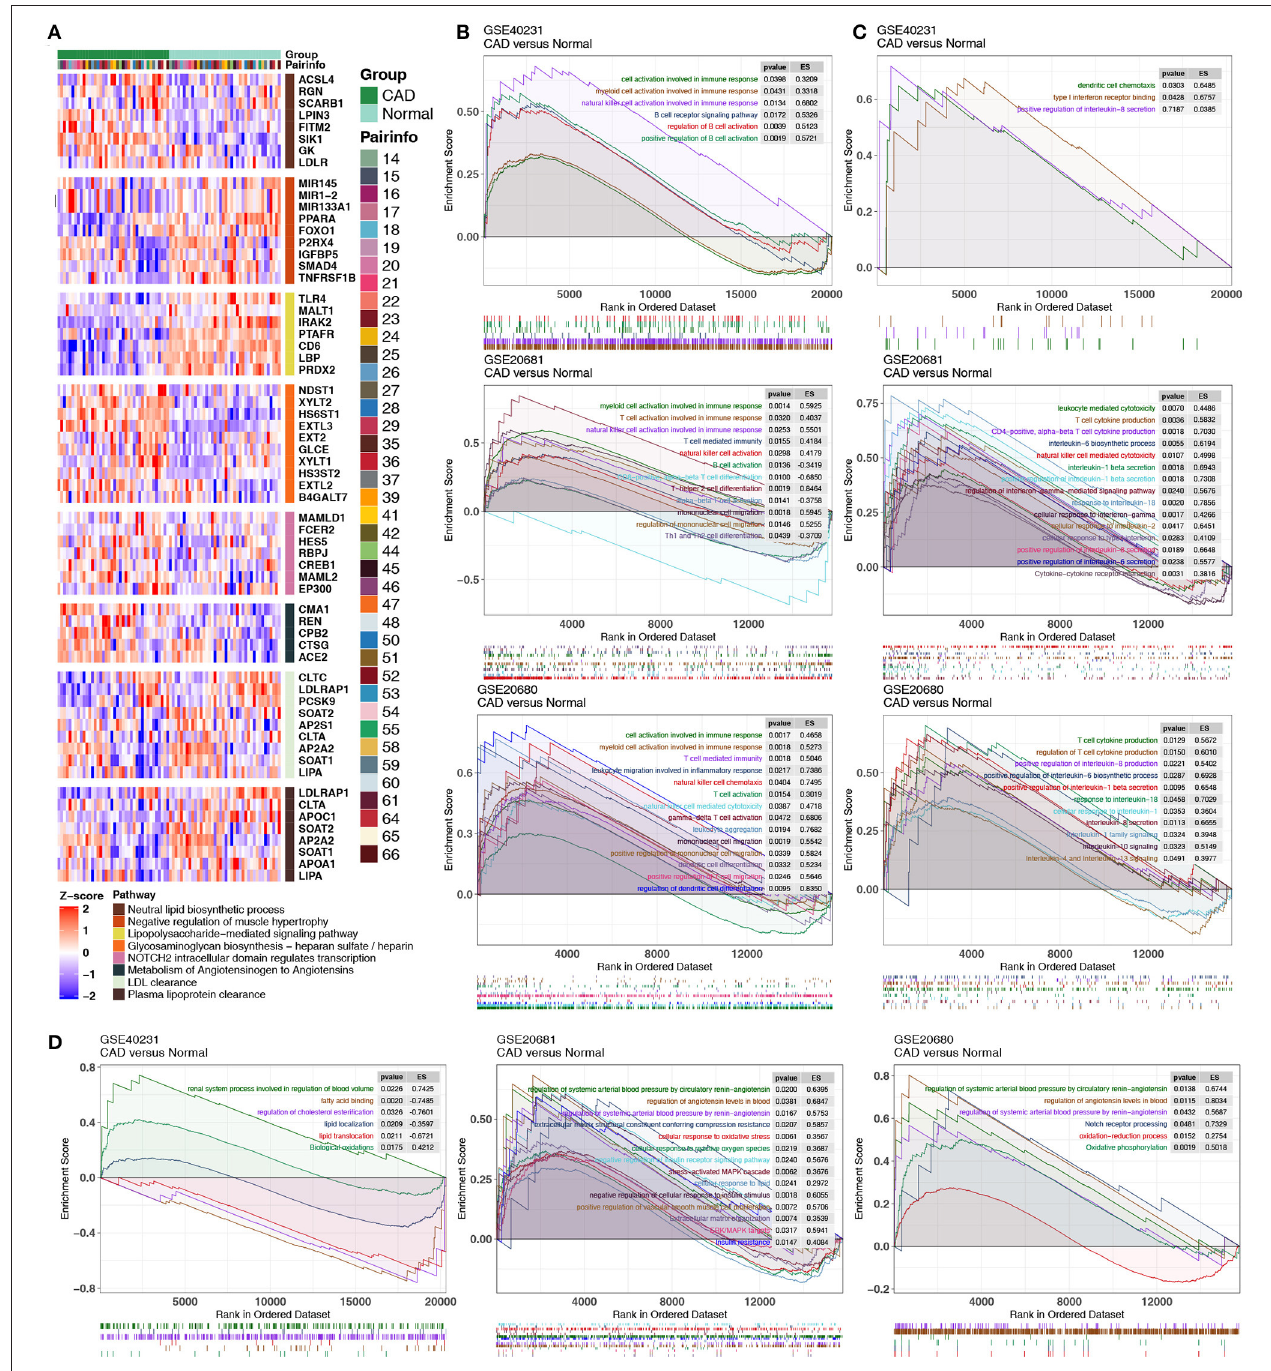
FIGURE 5 | (A) Heatmap of core genes in significantly enriched pathways between the CAD cases vs. the healthy controls in GSE40231. (B–D) GSEA of hallmark gene sets in the CAD cases and the healthy controls downloaded from MSigDB (GSE40231, GSE20681, and GSE20680). CAD cases were associated with activated immune cell- (B) , cytokine- (C), and inflammation-related pathways (D) . All transcripts were ranked as the log 2 (fold-change) between the CAD cases and the healthy controls. Each run was performed with 1,000 permutations. CAD, coronary artery disease; MsigDB, Molecular signatures